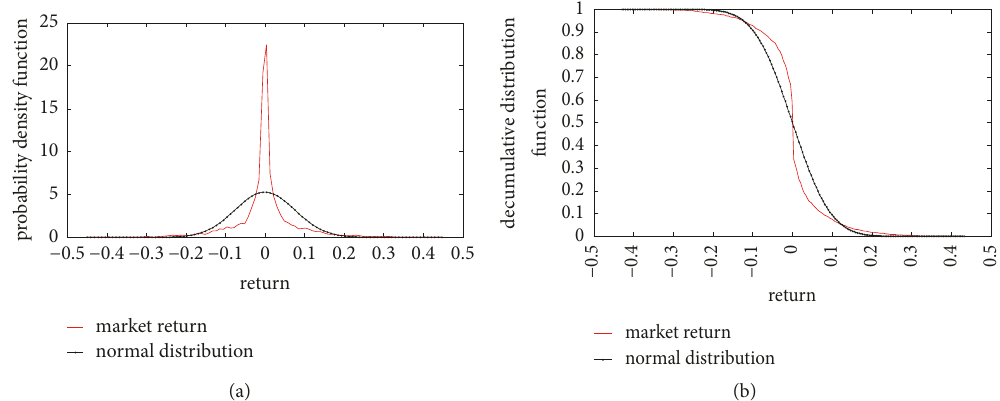
Figure 3: Distribution of return in the Bayes-EUTmarket (normal distribution has zero mean and the same std as that of the return series).